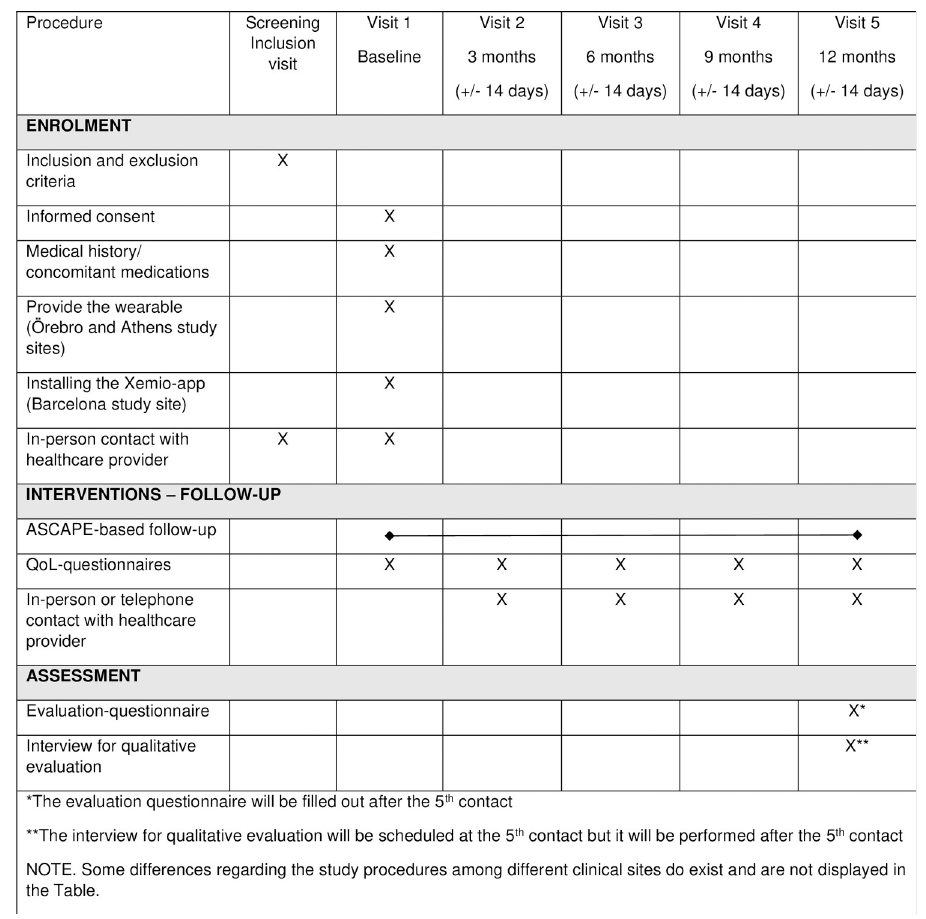
Fig 1. Generic flowchart of study procedures corresponding to ASCAPE-based follow-up